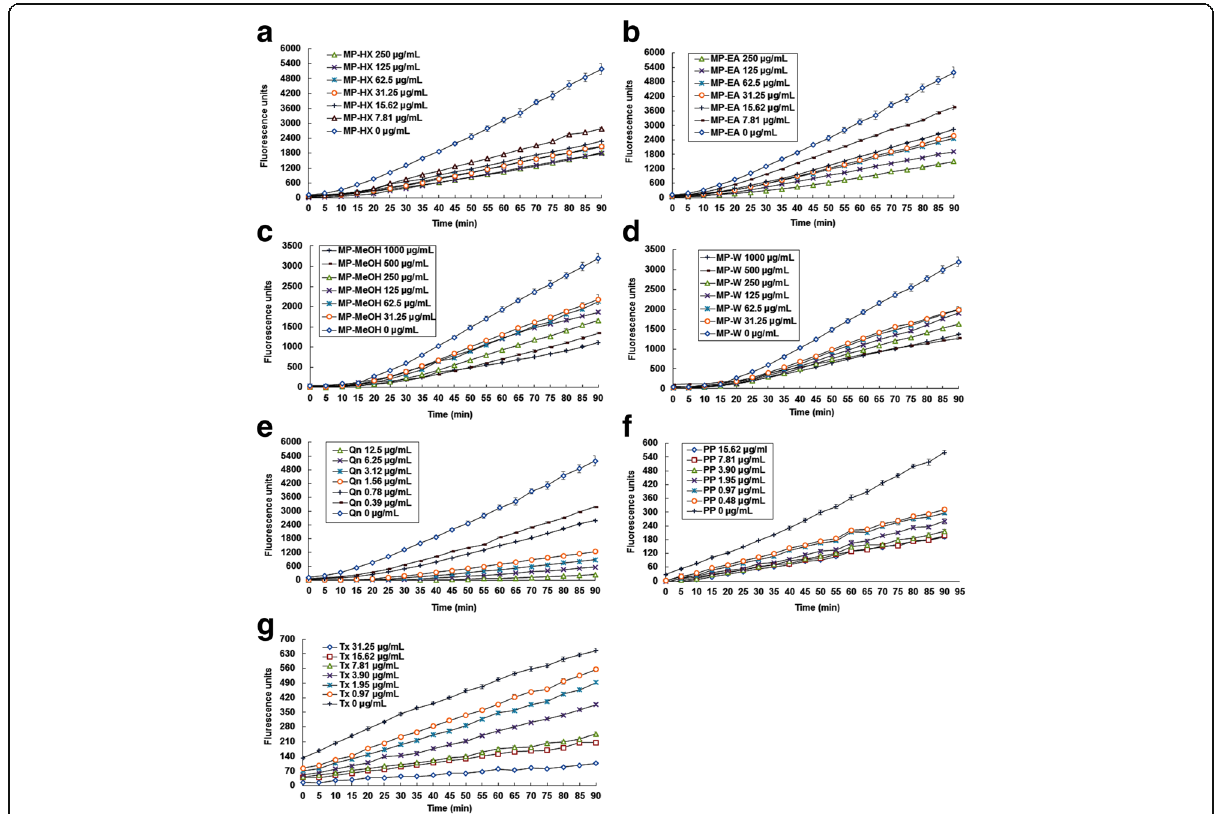
Fig. 2 Cellular antioxidant activity of MP leaf extracts. Inhibition of peroxyl radical-induced oxidation of DCFH 2 in Hs27 cells by a MP-HX, b MP-EA, c MP-MeOH, d MP-W, e Quercetin f Polyphenon-60 and g Trolox. The curves shown in each graph are from a single experiment (mean ± SD, n =